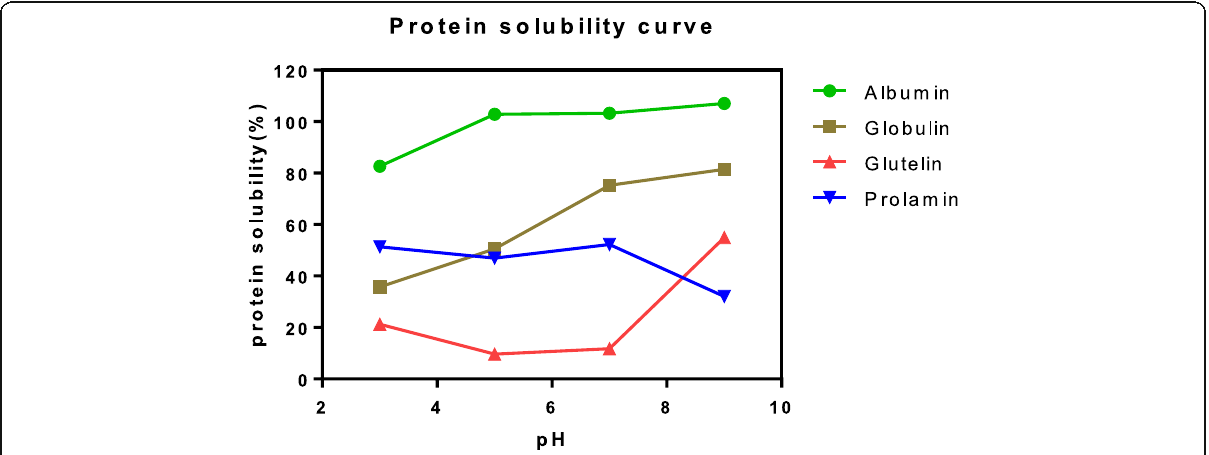
Fig. 4 Protein solubility curve of sesame protein fractions